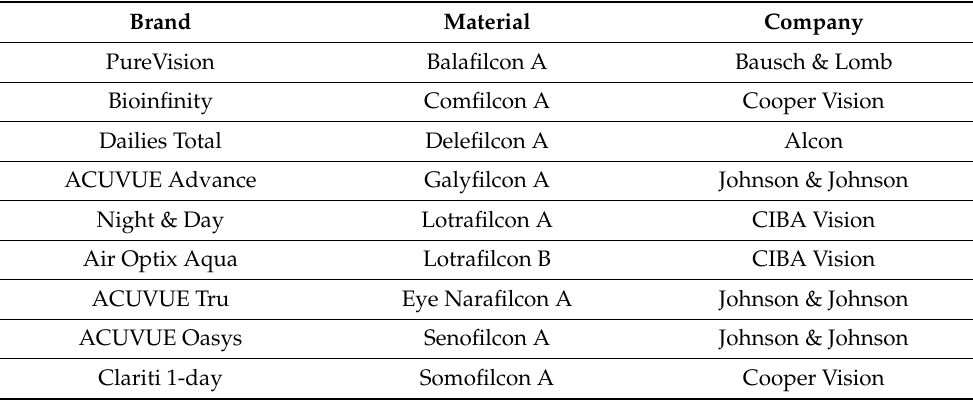
Table 3. Commercial contact lenses proposed as platform for ocular drug